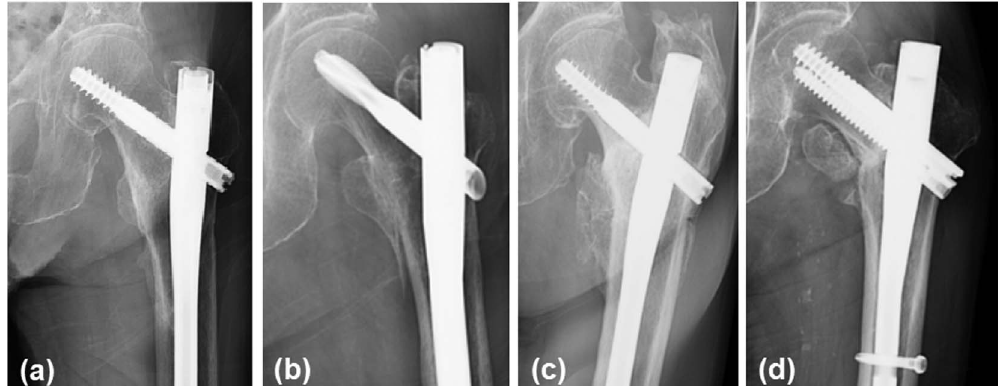
Figure 4. These radiographs show the deformity degree. (a) The radiograph presented mild deformity but showed complete bone union. Slight ossi fi cation was observed around the tape. (b) The radiograph presented moderate deformity but also showed complete bone union with 5 – 10 mm displacement of the lesser trochanter fragment. (c) The radiograph presented severe deformity with the displacement of lesser trochanter fragment to >1 cm from the base. (d) The radiograph showed ununited fragment. The displaced fragment shifted from the original position and was observed in the anterior proximal aspect of the femur. This may be affected by the iliopsoas muscle force.